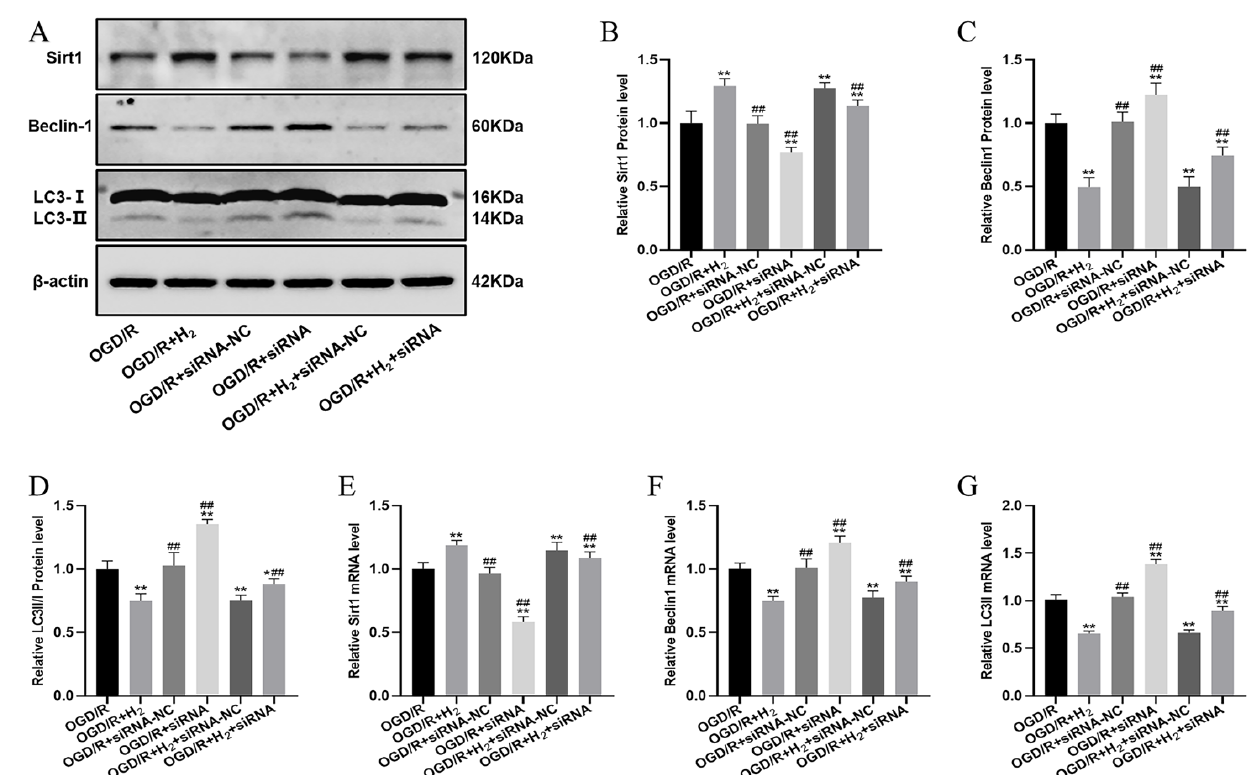
Figure 8. LincRNA-EPS knockdown abolished the effects of H 2 on Sirt1 expression and Figure 8. LincRNA- EPS knockdown abolished the effects of H 2 on Sirt1 expression and autophagy. ( A ) Sample bands from a Western blotting experiment. ( B – D ) Quantification of Sirt1, Beclin− 1, and